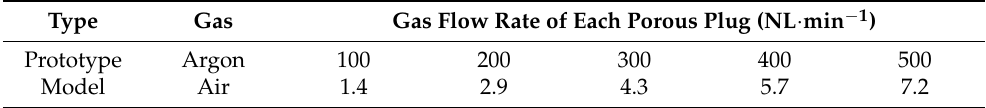
Table 3. Gas flow rate of prototype and